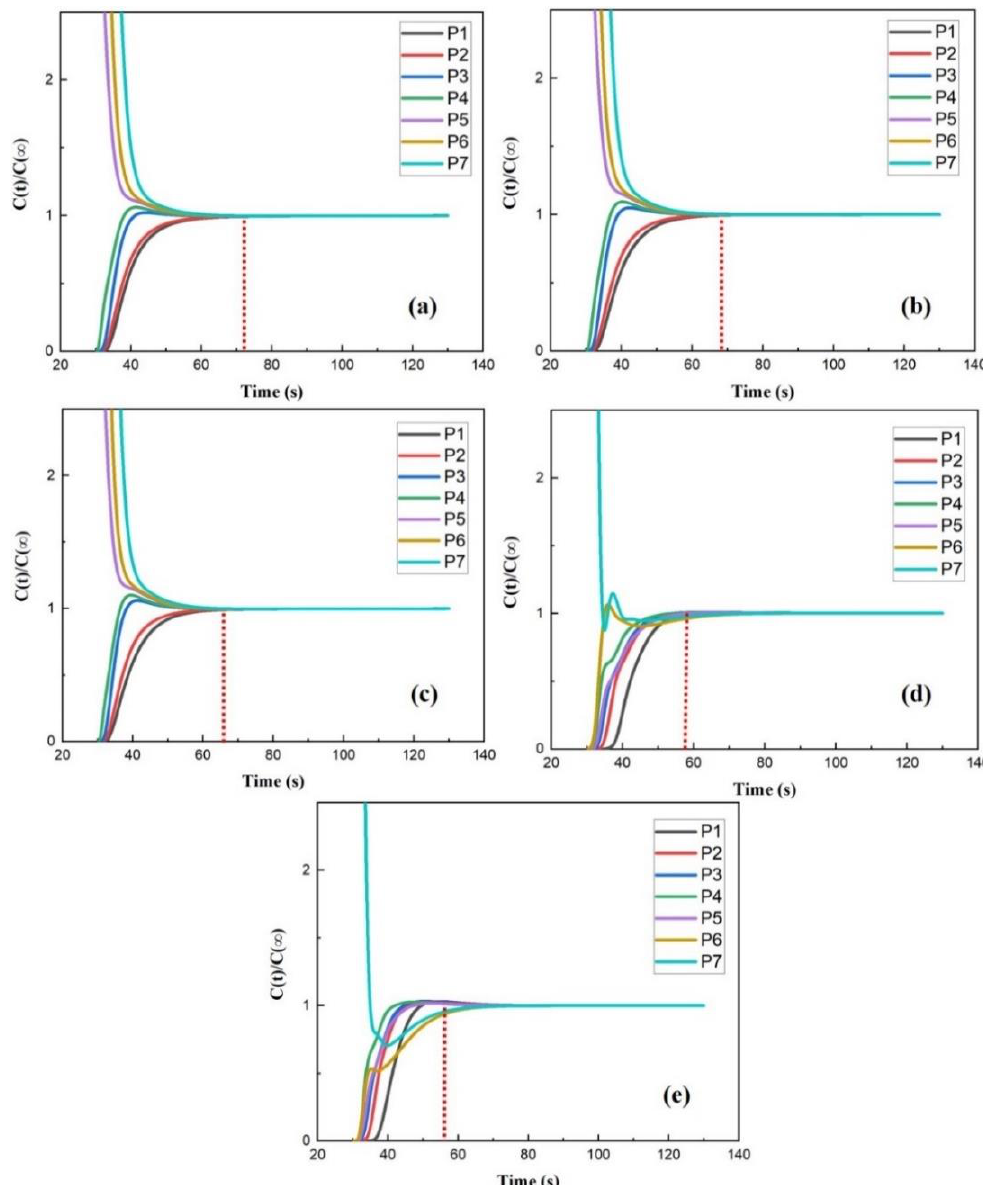
Figure 13. The change of tracer concentration of monitoring points with time at IRS of ( a ) 180 rpm, ( b ) 200 rpm, ( c ) 220 rpm, ( d ) 240 rpm, and ( e ) 260 rpm.